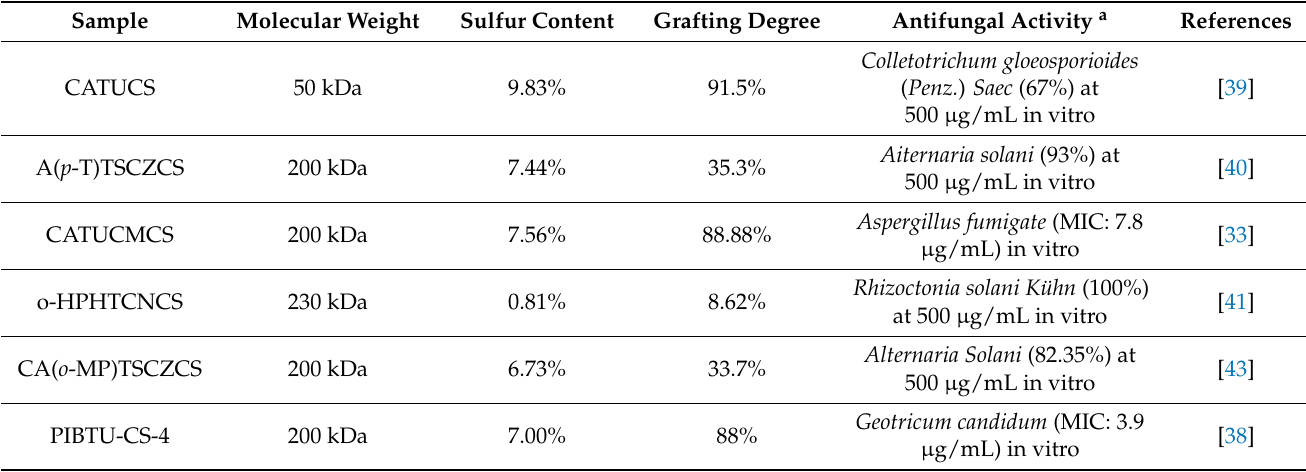
Table 1. Antifungal properties of some sulfonated chitosan